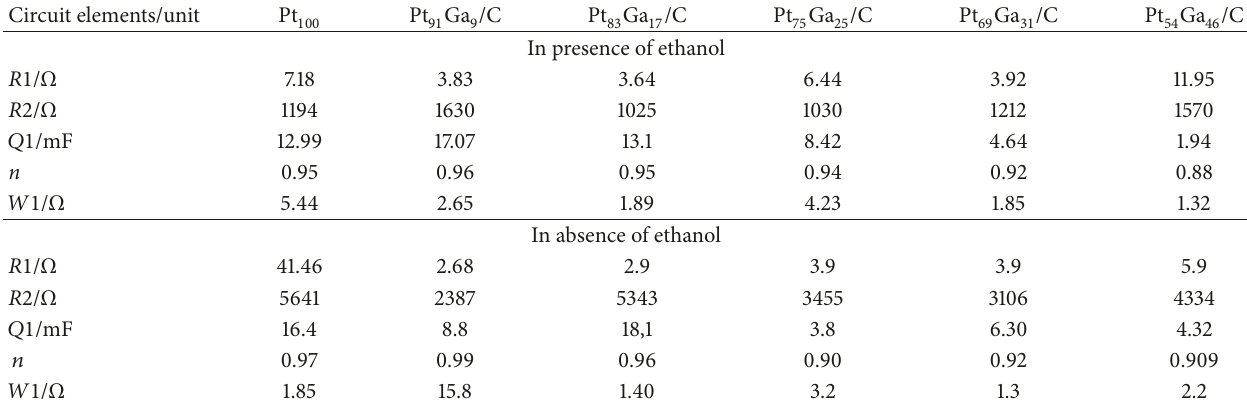
Table 5: Fitted circuit [ R 1( R 2[ Q 1 W 1])] parameters of the PtGa/C electrocatalysts ∗ .